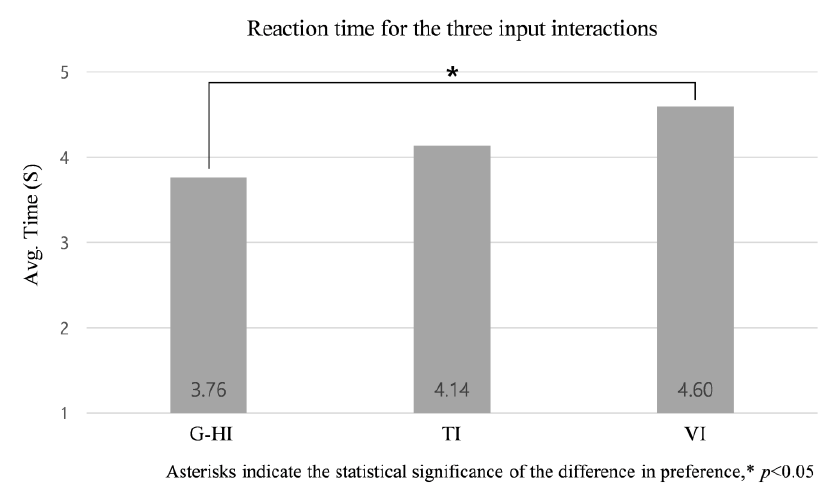
Figure 5. Average of reaction time for each input interaction (gaze-head input, touch input, voice input).